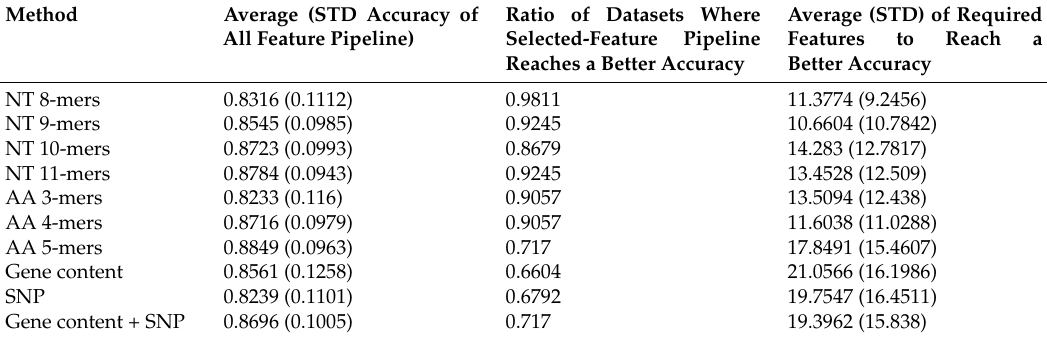
Table A66. Evaluation of the performance of the selected-feature pipeline, compared to the all-features pipeline.